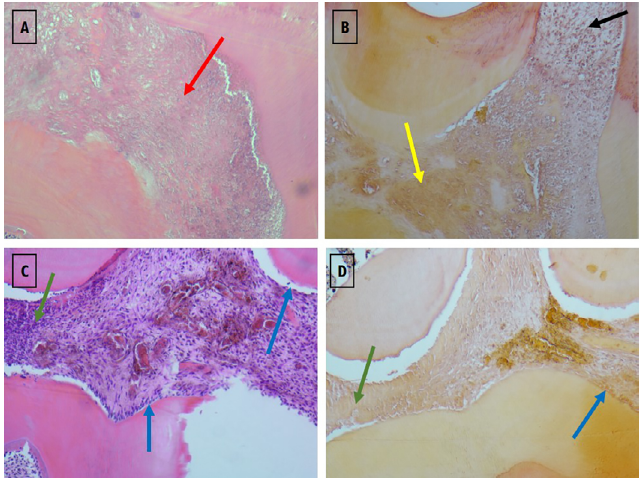
Figure 7- Images of histological sections in groups 3 (images A and B) and 4 (images C and D), in which therapies with WhiteProRoot ® MTA and Biodentine™ were performed, at 3 days of follow-up. Images A (Group 3) and C (Group 4) were stained with H&E and obtained with 100x magnification. The B (Group 3) and D (Group 4) images were stained with Alizarin Red S and obtained with 100x magnification. Red arrow – disorganized pulpal tissue with increased loose connective tissue; yellow arrow – disorganized pulp tissue with the presence of calcium deposits; black arrow – area corresponding to normal pulp tissue organization; green arrow – disorganized pulpal tissue with slight inflammatory infiltrates; blue arrow – odontoblast monolayer